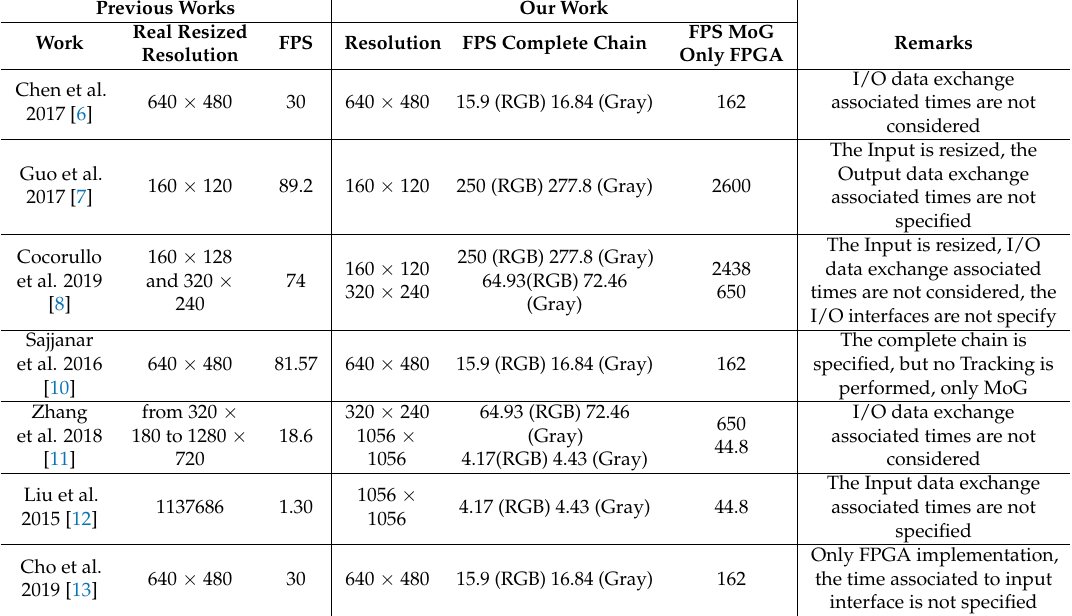
Table 7. FPGA mixture of Gaussian performance